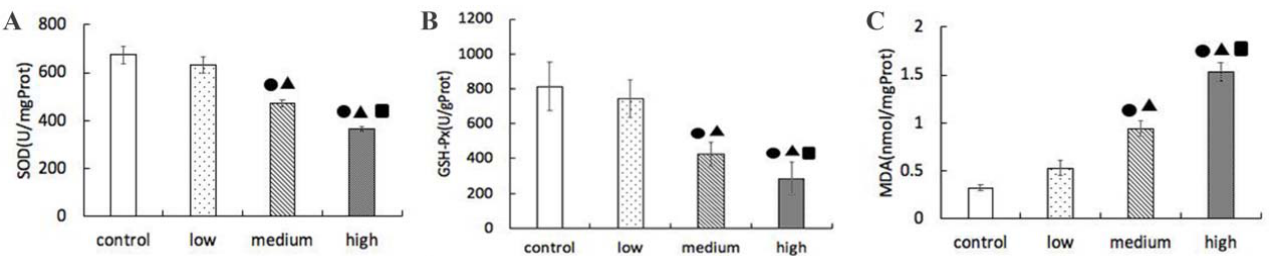
Figure 5. Effects of La 2 O 3 NPs on SOD, GSH-Px activity, and MDA content in lung tissue of rats in each group. ( A ) SOD level. ( B ) GSH-Px level. ( C ) MDA activity. Note: ● , compared with the control group, p < 0.05; ▲ , compared with the low group, p < 0.05; ■ , compared with the medium group, p < 0.05.